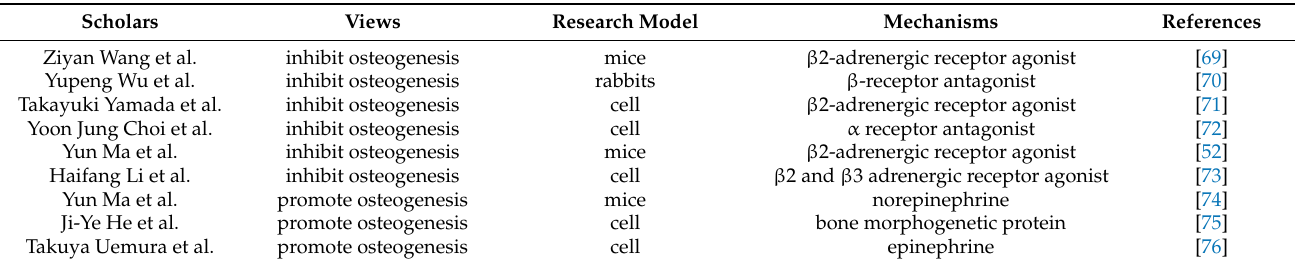
Table 1. Sympathetic regulation of osteogenesis.